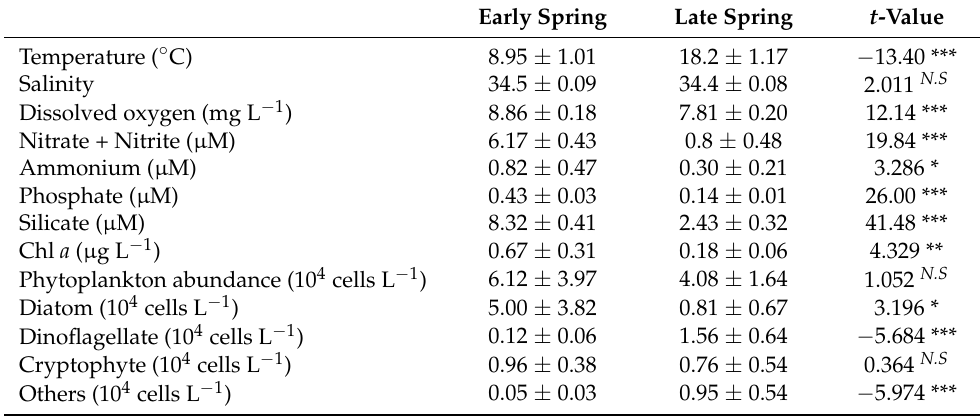
Table 3. Abiotic and biotic factors in early spring (Stns. 6–13) and late spring (Stns. 19–28). Values are means ± standard errors and results were compared using a t -test. p > 0.05: N.S ; p < 0.05: *; p < 0.01: **; p < 0.001: ***.